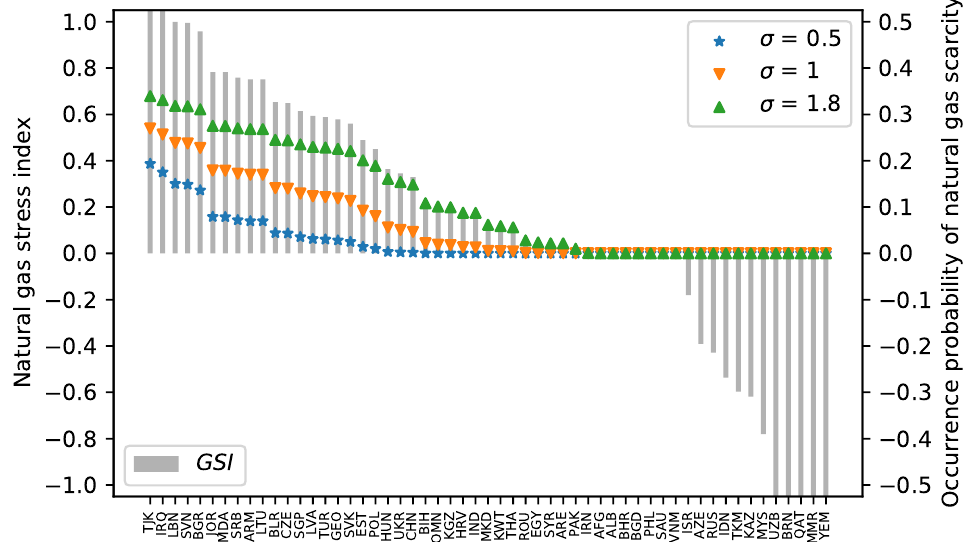
Figure 1. Natural gas stress index GSI and the inferred probability of natural gas scarcity under different σ values. The nation-sectors are sorted with decreasing GSI .